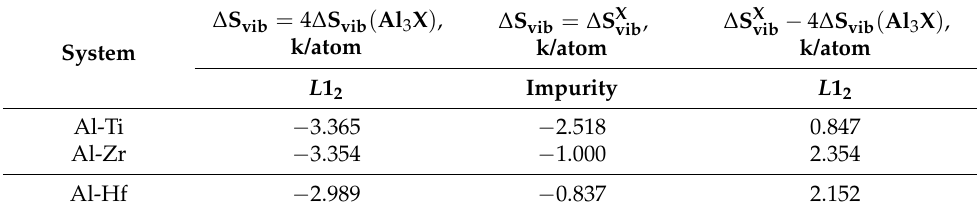
Table 3. Vibrational entropy of Al 3 X (X = Ti, Zr, Hf) compounds and TM atoms.